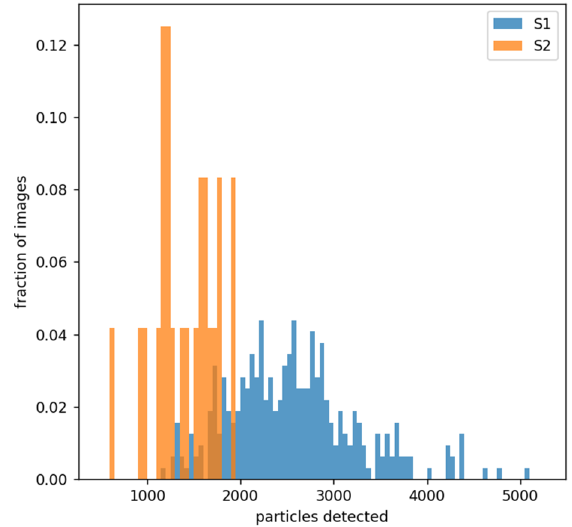
Figure 5. Number of nanoparticles that were detected for S1 (blue) and S2 (orange) images.